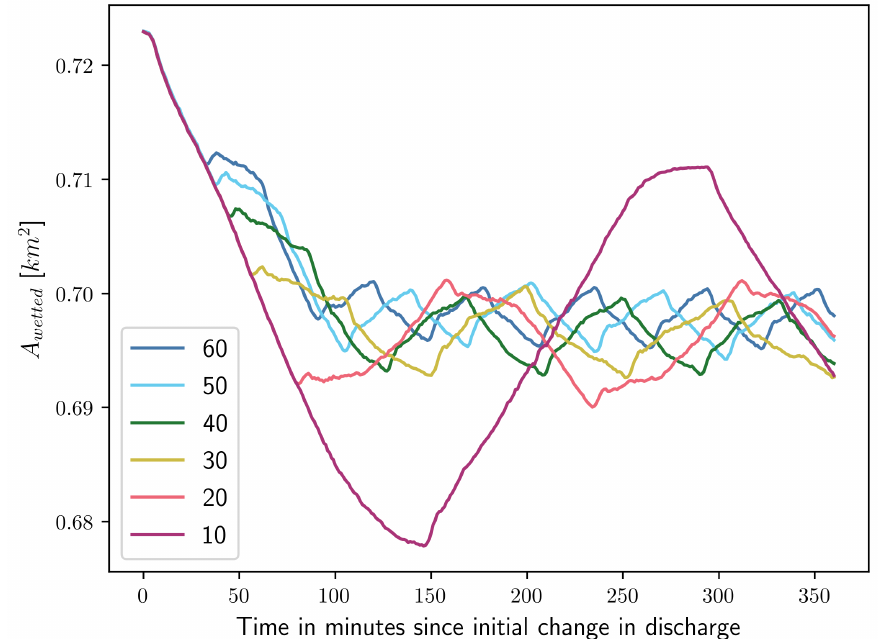
Figure 12. Total wetted area dynamics for the six different scenarios. The legend is in flow changes per